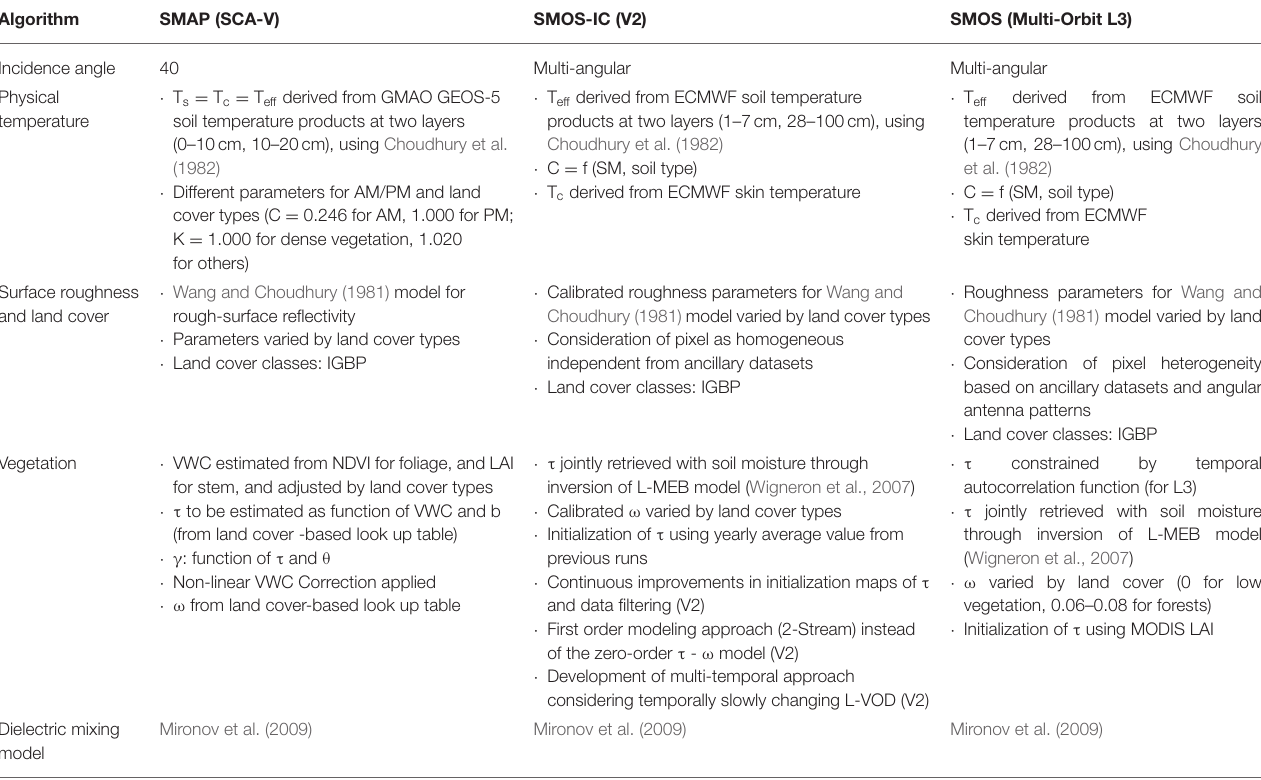
TABLE 1 | Summary of key differences of SMAP, SMOS-IC, and SMOS retrieval algorithms. Algorithm Incidence